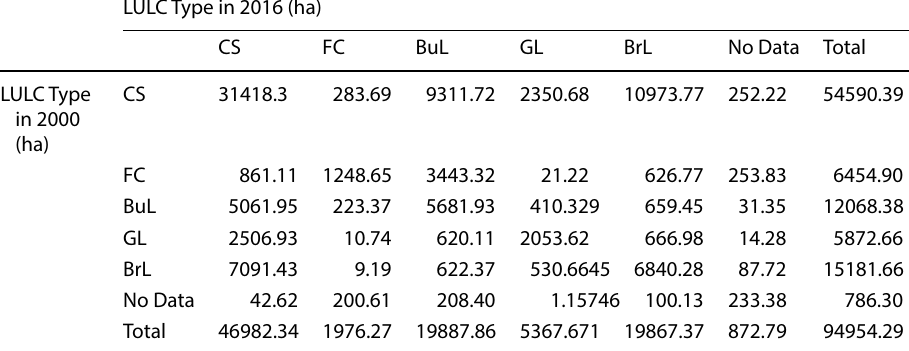
Table 9 LULC conversion matrix of the Gubalafto District between 2000 and 2016